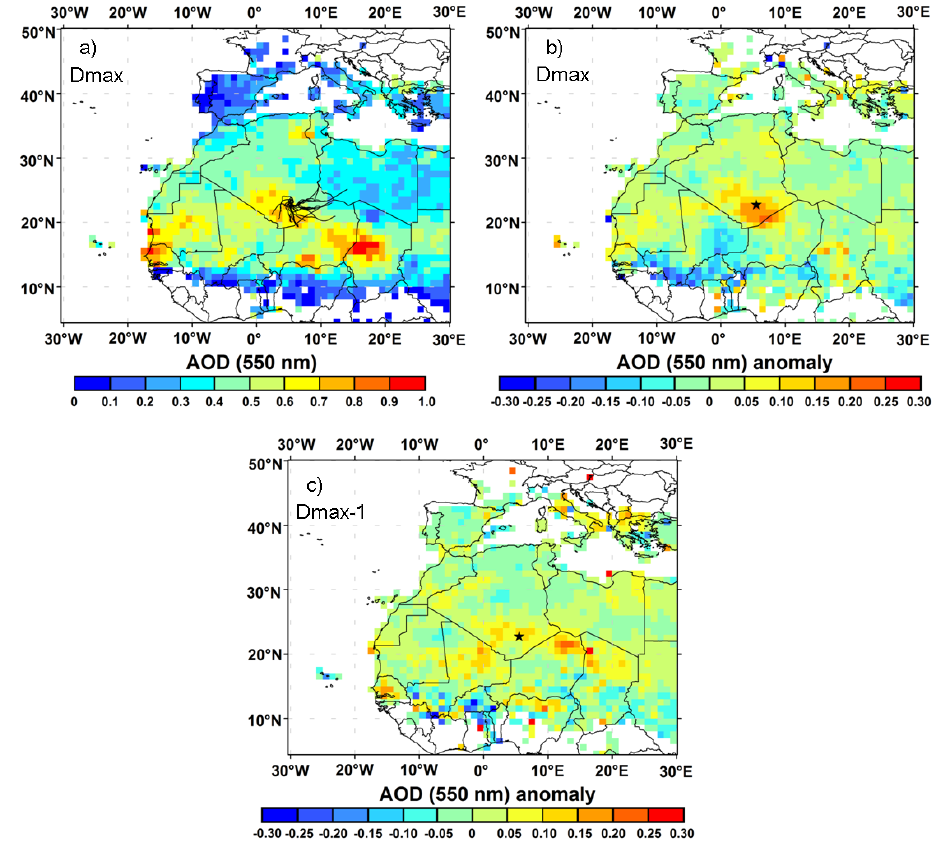
Figure 12. Composite MODIS Deep Blue 550nm (a) AOD and AOD-averaged anomaly corresponding (b) to the 21 days of maximum (D max ) AOD at Tamanrasset during MCS events, and (c) to the previous day for each maximum AOD event (D max -1). The Tamanrasset station is marked with a black star. Two-day HYSPLIT back trajectories arriving at Tamanrasset at ground level (black solid lines) are also displayed in panel